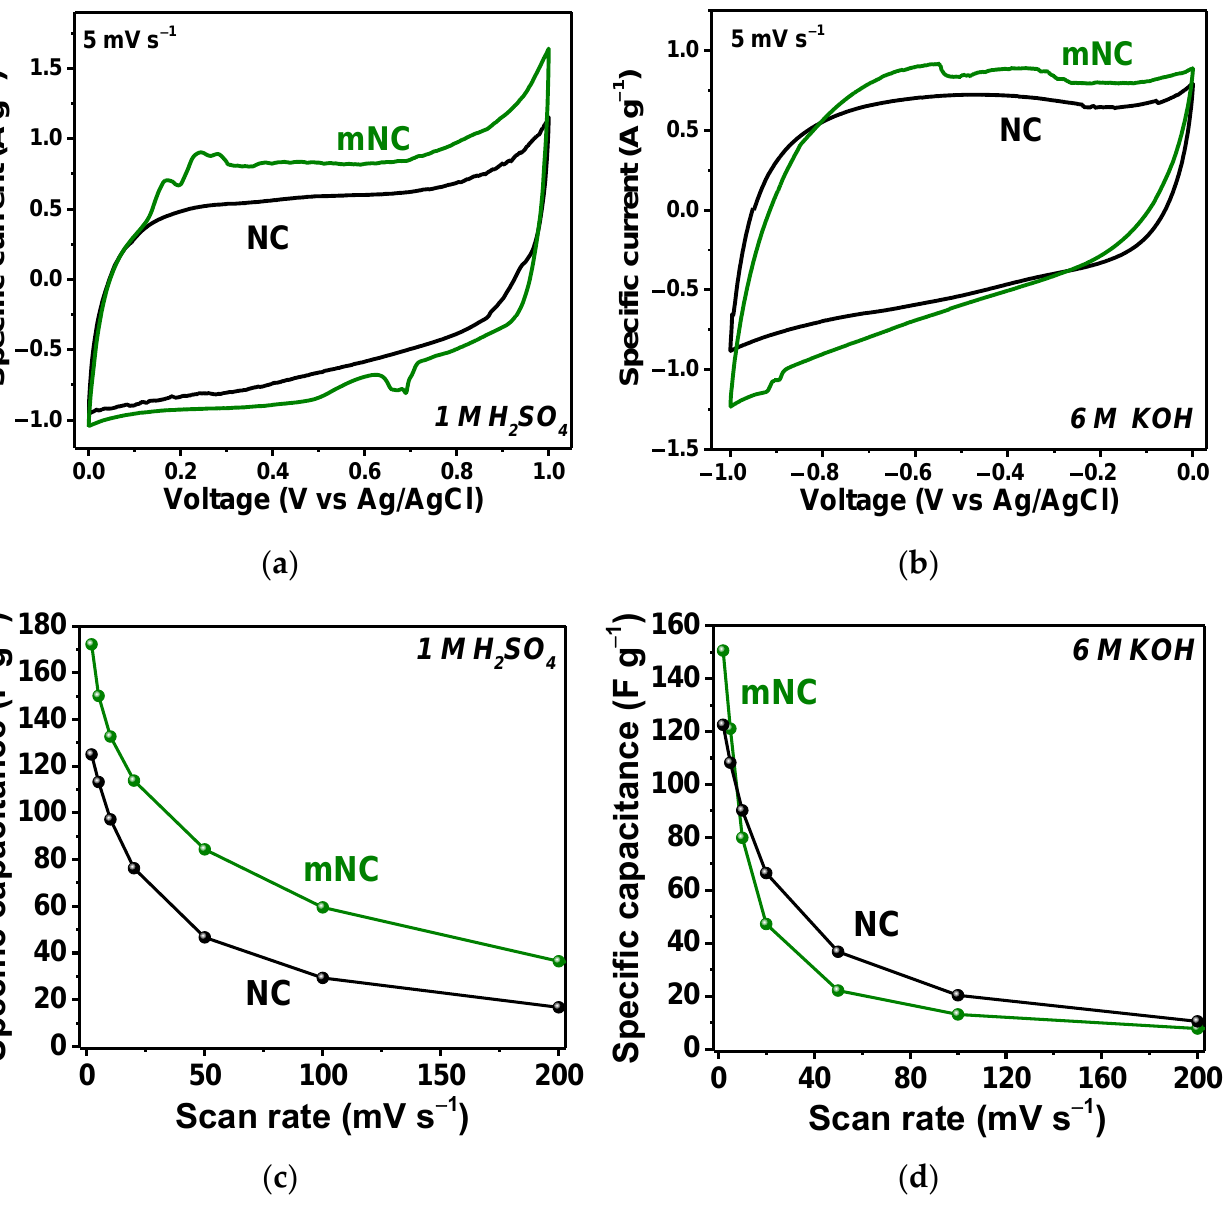
Figure 5. Electrochemical performances of NC and mNC electrodes in aqueous SCs: CV curves at 5 mV s − 1 in ( a ) 1 M H 2 SO 4 and ( b ) 1 M KOH electrolytes; Gravimetric capacitance at scan rates of 2–200 mV s − 1 in ( c ) 1 M H 2 SO 4 and ( d ) 1 M KOH electrolytes.